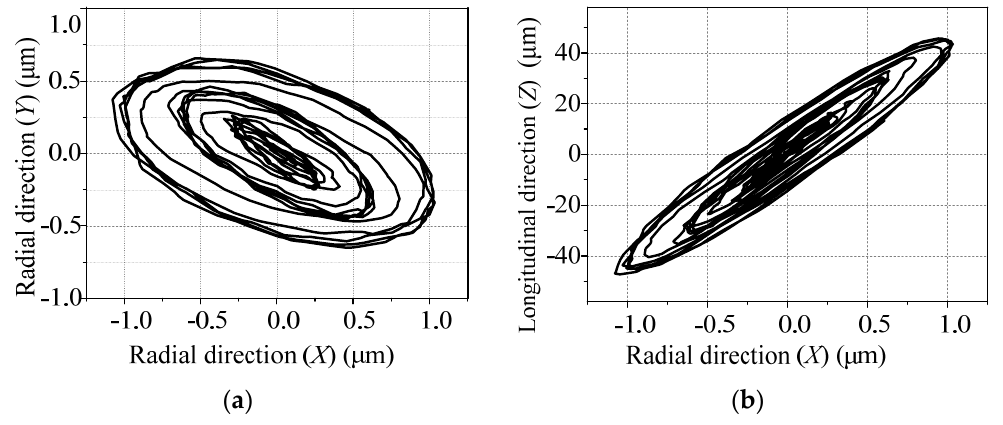
Figure 11. Trajectory of the points at the top end of the power-superimposing vibrator driven by sinusoidal voltages with 120° difference in phase between each other. ( a ) Trajectory in XY plane. ( b ) Trajectory in XZ plane.